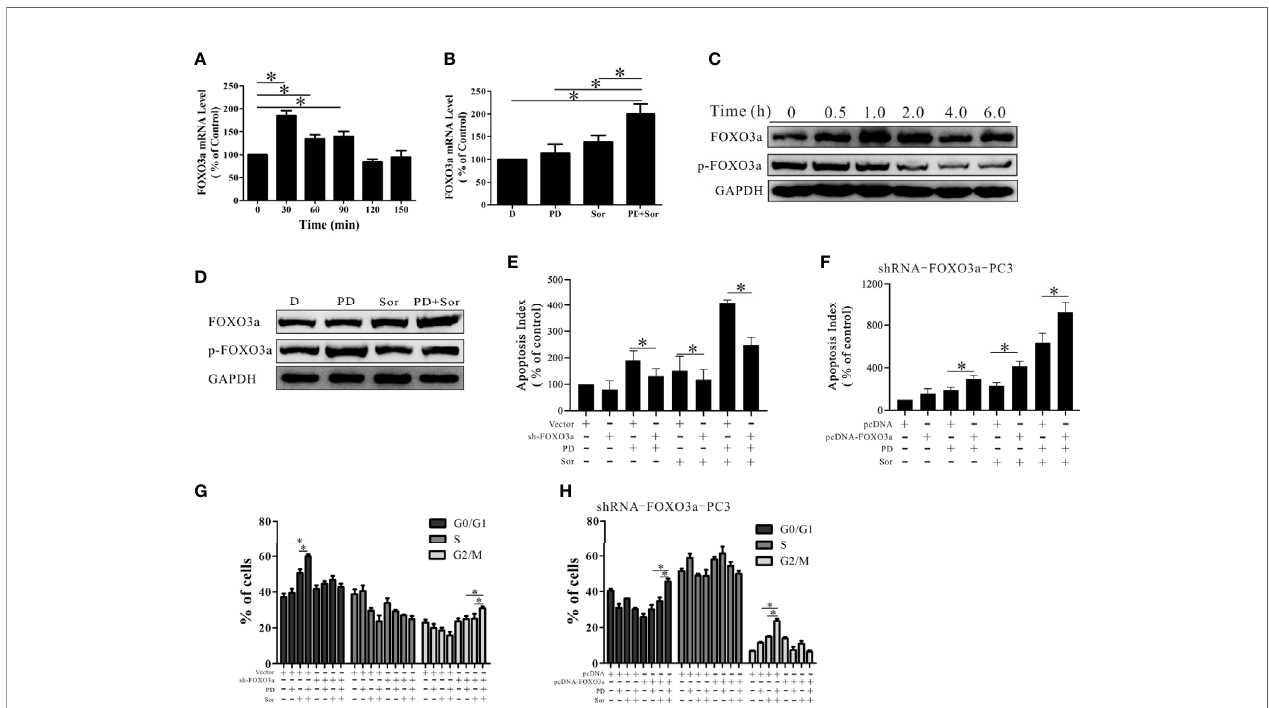
FIGURE 6 | PD promotes the anti-tumor effects of sorafenib by increasing the activity and expression of FOXO3a. (A) The mRNA expression level of FOXO3a after treatment of PC3 cells with 10 m M PD plus 10 m M sorafenib. (B) The mRNA expression level of FOXO3a after treatment with 10 m M PD alone, 10 m M sorafenib alone or PD plus sorafenib for 30 min. (C) The protein expression levels of FOXO3a and p-FOXO3a after treatment with 10 m M PD plus 10 m M sorafenib. (D) The protein expression levels of FOXO3a and p-FOXO3a after treatment with 10 m M PD alone, 10 m M sorafenib alone or PD plus sorafenib for 30 min. (E) The effects of PD, sorafenib or PD plus sorafenib on early apoptosis in cells with FOXO3a inhibition. (F) The changes in apoptosis of shRNA-FOXO3a PC3 cells with cDNA-FOXO3a treated with PD, sorafenib or PD plus sorafenib. (G) The effects of PD, sorafenib or PD plus sorafenib on the cell cycle distribution after FOXO3a inhibition and pre- treatment with 2 mM thymidine for 24 h. (H) The effects of PD, sorafenib or PD plus sorafenib on the cell cycle distribution of shRNA-FOXO3a PC3 cells after transfection with cDNA-FOXO3a for 6 h and pre-treatment with 2 mM thymidine for 24 h. * p <